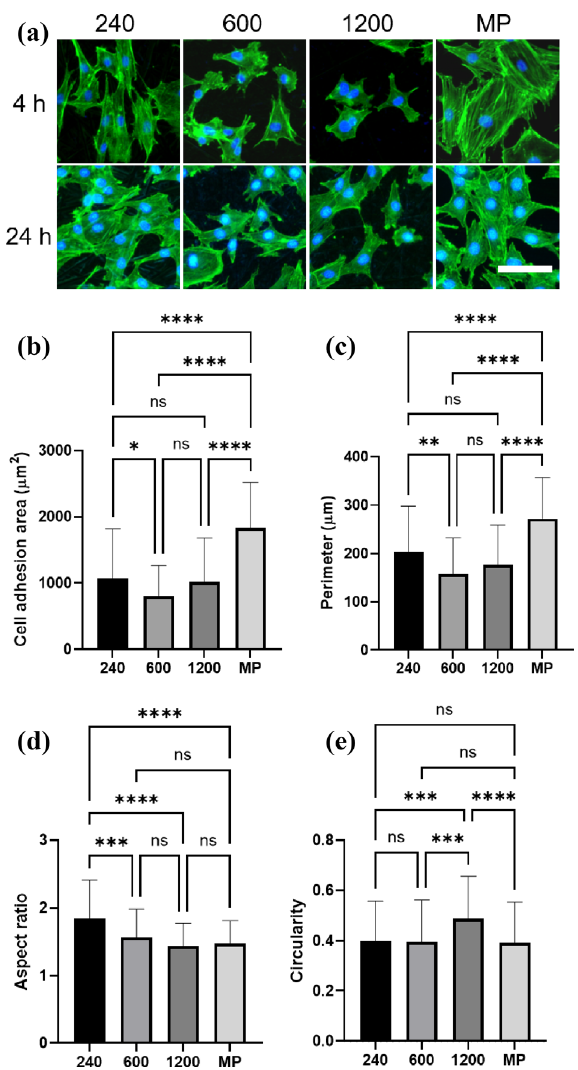
Figure 2. Cell attachment behavior on Ti with disordered abrasive scratches. Fluorescent microscopic images of the cells cultured on the Ti with disordered abrasive scratches for 4 h and 24 h (a). The cells-stained F-actin (green) and nuclei (blue). The scale bar indicates 100 μm. Cell morphological parameter of cell attachment area ( a ), perimeter ( b ), aspect ratio ( c ), and circularity ( d ) calculated from the images of 4 h cultivation. The data shown are mean ± SD. *p < 0.05; **p < 0.01; ***p < 0.005; and ****p <